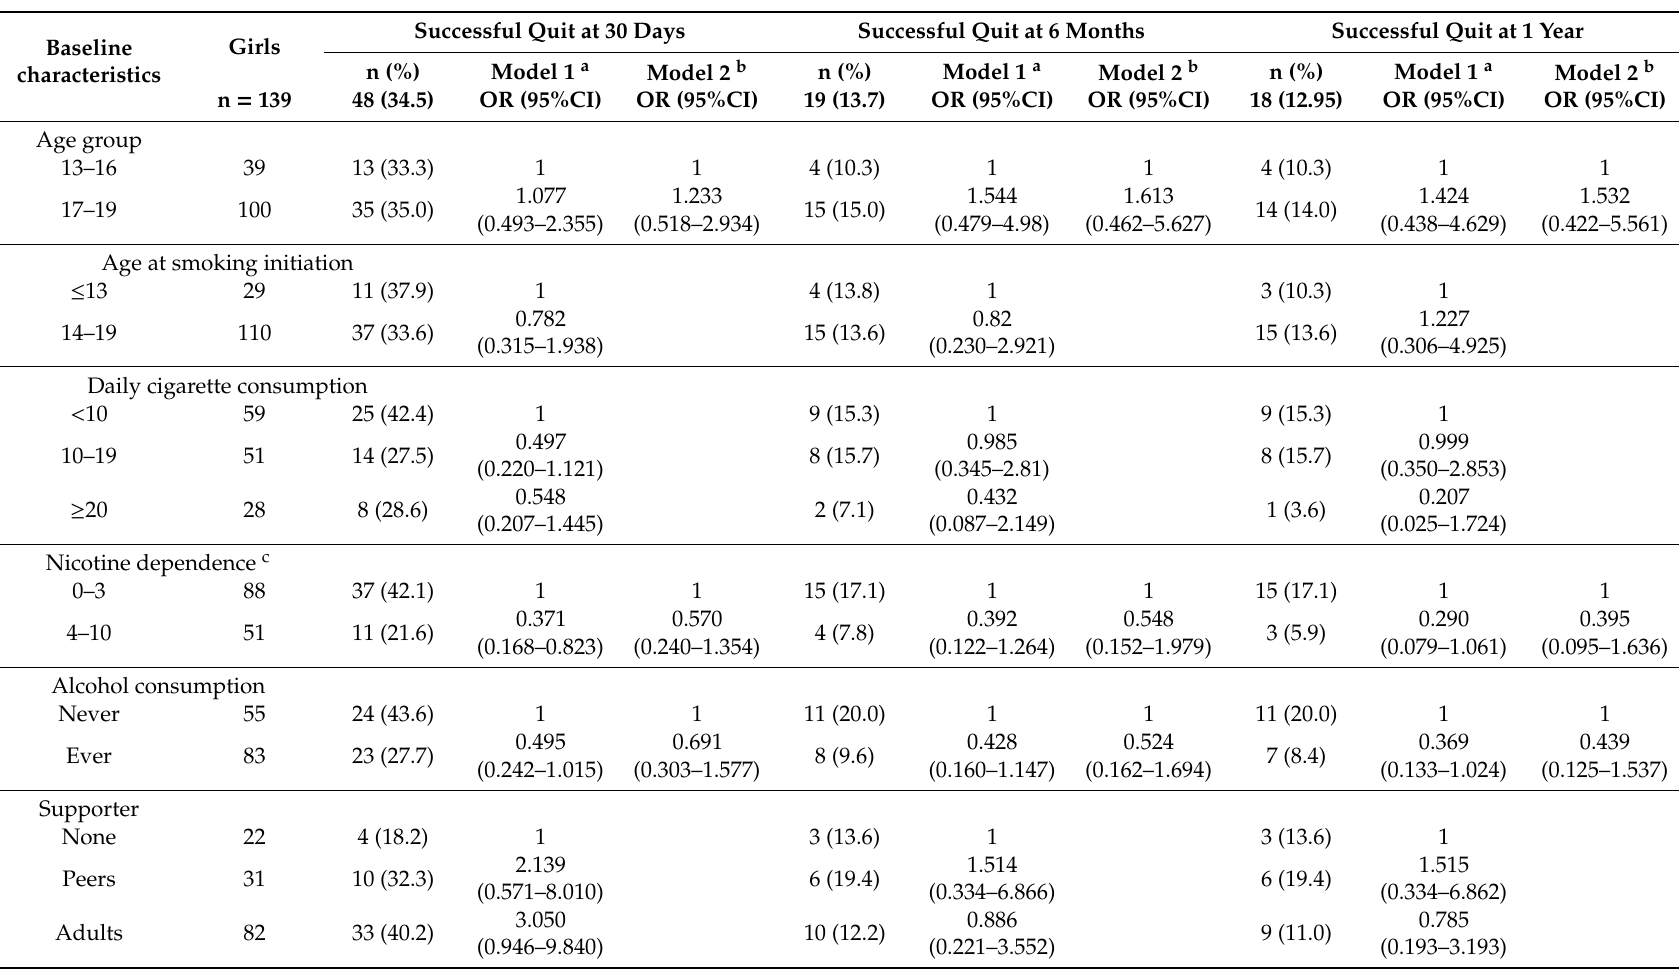
Table 4. Odds ratios and confidence intervals of potential factors associated with successful quit among adolescent Quitline users (Girls). Baseline